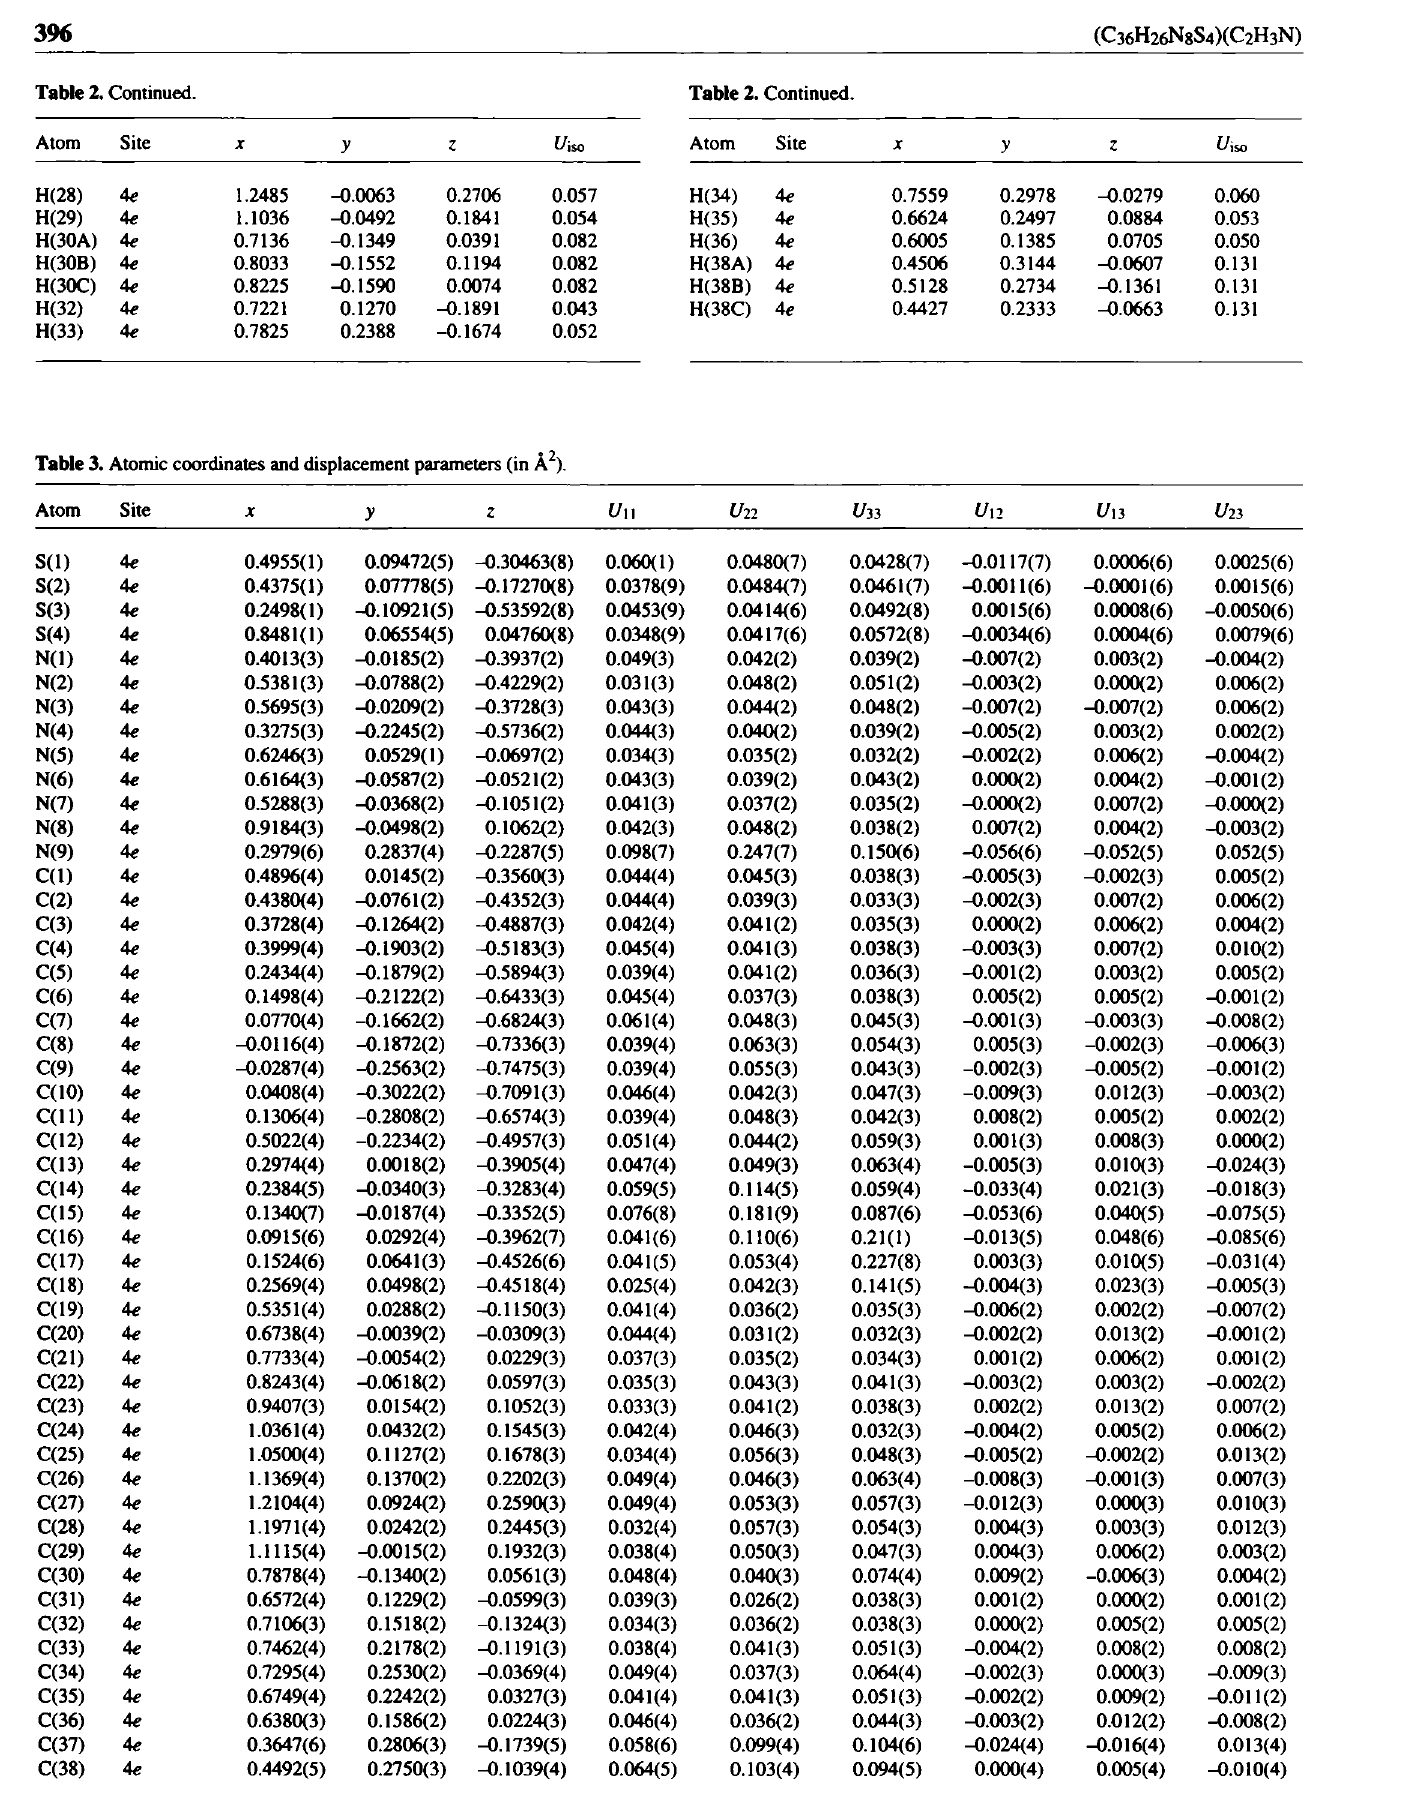
Table 3. Atomic coordinates and displacement parameters (in Â 2